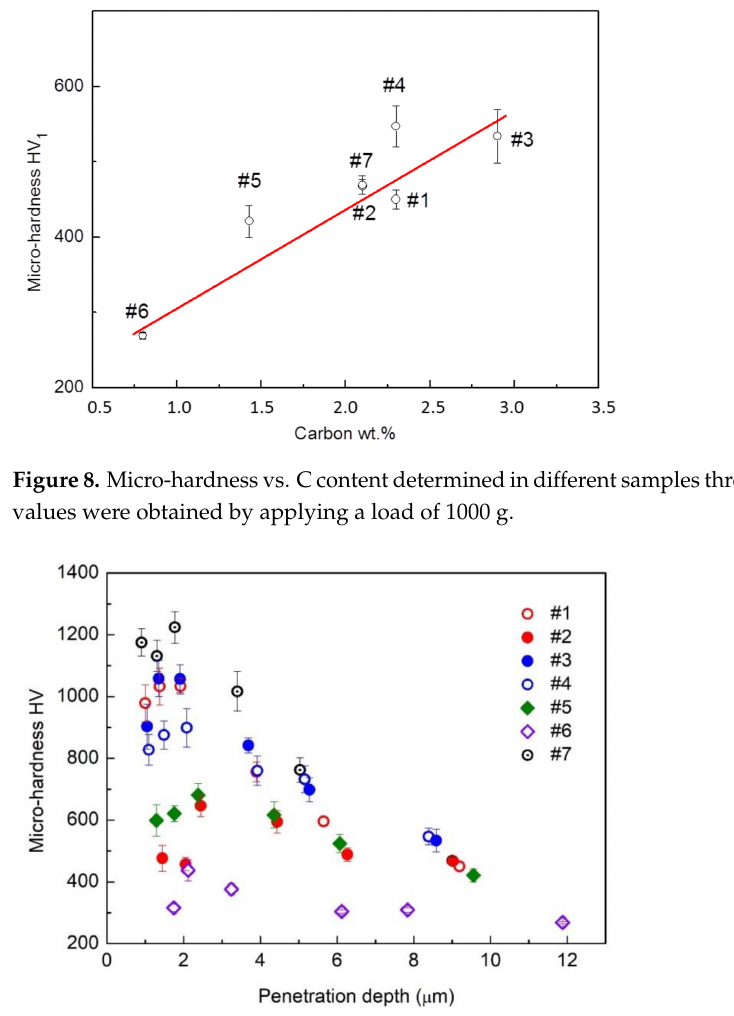
Figure 9. Micro-hardness vs. penetration depth. The tests have been carried out on the plasma exposed surface by using 6 different loads (25, 50, 100, 300, 500 and 1000 g). Each point in the curves corresponds to a specific